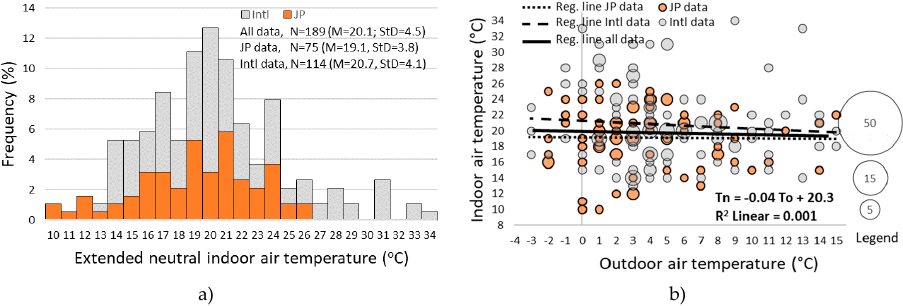
Figure 4. Indoor and outdoor temperature at TSV ( − 1, 0, +1): ( a ) Frequency percentage distribution of neutral indoor air temperature; ( b ) correlation between indoor and outdoor air temperature at the vote.